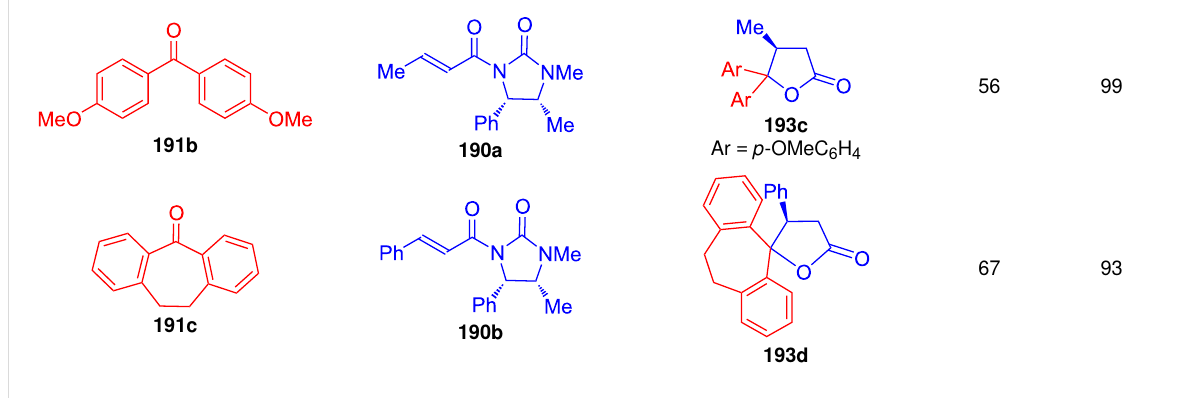
Table 1: Enantioselective electroreductive coupling of diaryl ketones with α , β -unsaturated carbonyl compounds containing chiral auxiliaries.